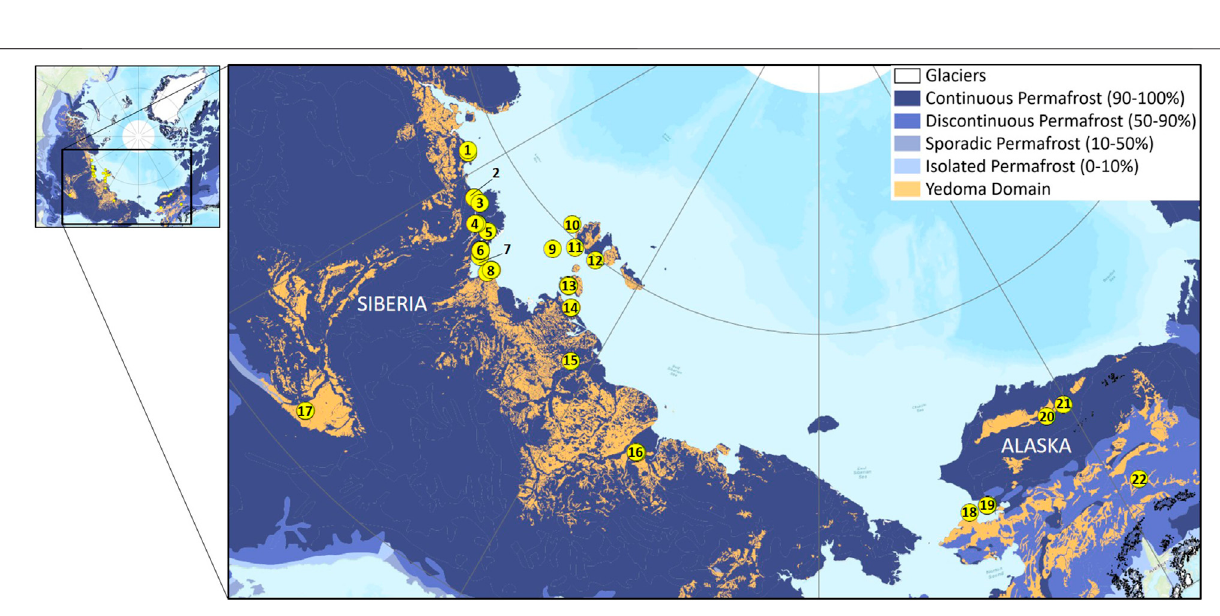
FIGURE 2 | Location of the studied permafrost sites from the Yedoma Domain. 1. Cape Mamontov Klyk; 2. Nagym (Ebe Sise Island); 3. Khardang Island; 4. Kurungnakh Island; 5. Sobo Sise Island; 6. Bykovsky Peninsula; 7. Muostakh Island; 8. Buor Khaya Peninsula; 9. Stolbovoy Island; 10. Belkovsky Island; 11. Kotel ’ ny Island;12.BungeLand;13.Bol ’ shoyLyakhovskyIsland;14.OyogosYarcoast;15.Kytalyk;16.DuvannyYar;17.Yukechi;18.Kitluk;19.BaldwinPeninsula;20.Colville; 21. Itkillik; 22. Vault Creek tunnel. Yedoma domain coverage from Strauss et al. (2016,